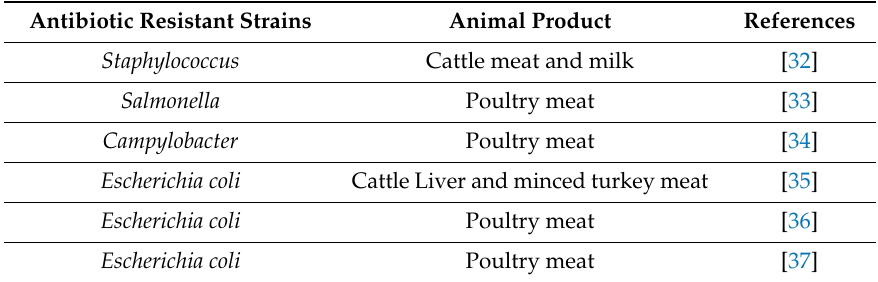
Table 1. Examples of antibiotic resistant strains in animal